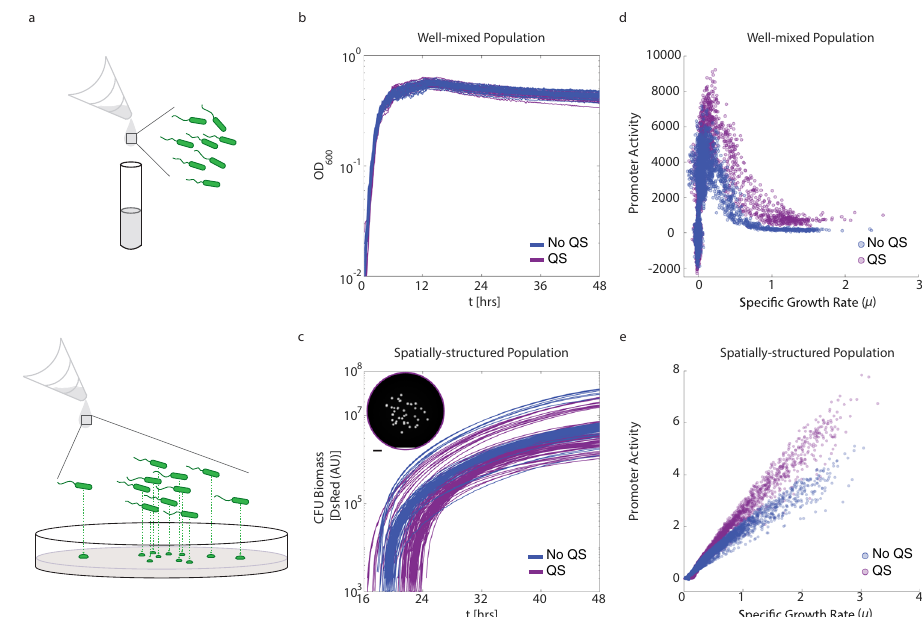
Fig. 1 Rhamnolipid production differs between liquid culture and surface-attached P. aeruginosa . a Cartoon depictions of liquid and spatially-structured environments used in this study. b Optical density timeseries describing P. aeruginosa growth in liquid culture. [Blue] Biomass growth without exogenous quorum signals. [Purple] Biomass growth with exogenous quorum signals. c DsRed fl uorescent timeseries generated from a custom-built imager (Supplementary Fig. 1) and custom software (Supplementary Fig. 3) describing P. aeruginosa growth in colony forming units (CFU). [Blue] Biomass growth without exogenous quorum signals [Purple] Biomass growth with exogenous quorum signals added to the plate media. [Inset] Example plate showing colonies at 48 h. Scale bar 1 cm. d Promoter activity dGFP quorum signals [Purple] with exogenous quorum signals. e Promoter activity dGFP without exogenous quorum signals [Purple] with exogenous quorum signals provided in the plate